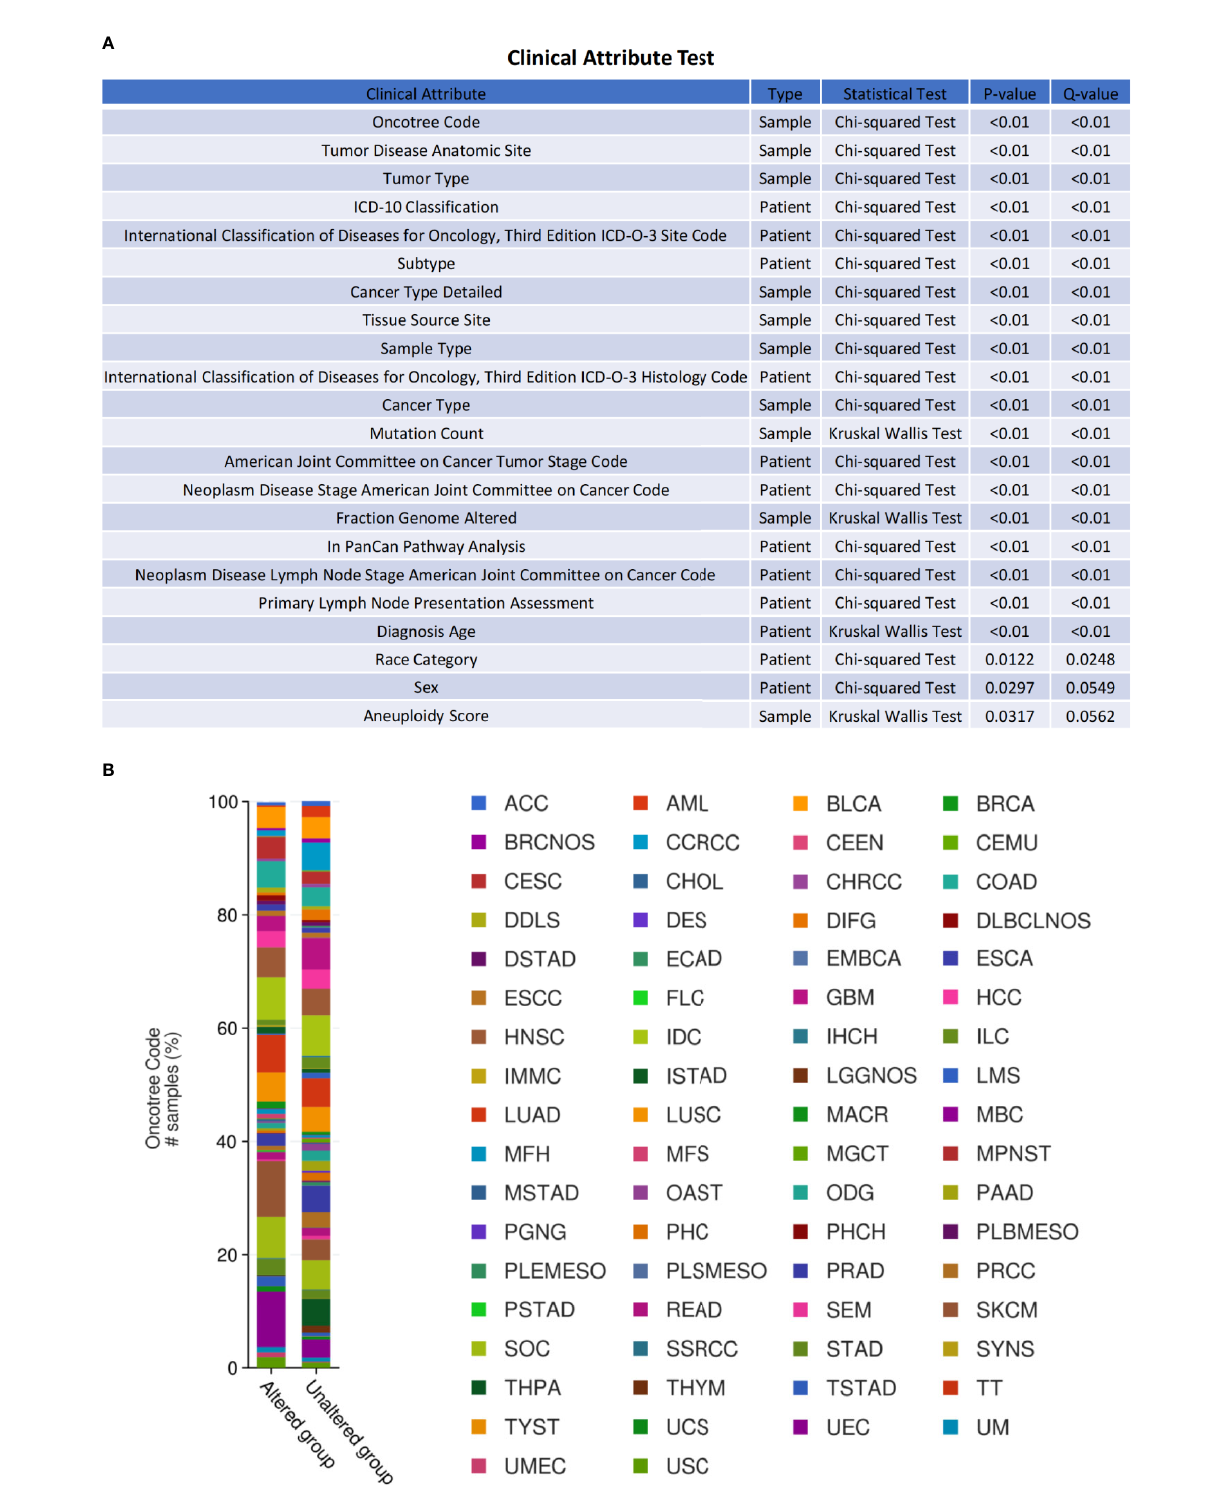
Frontiers in Oncology |